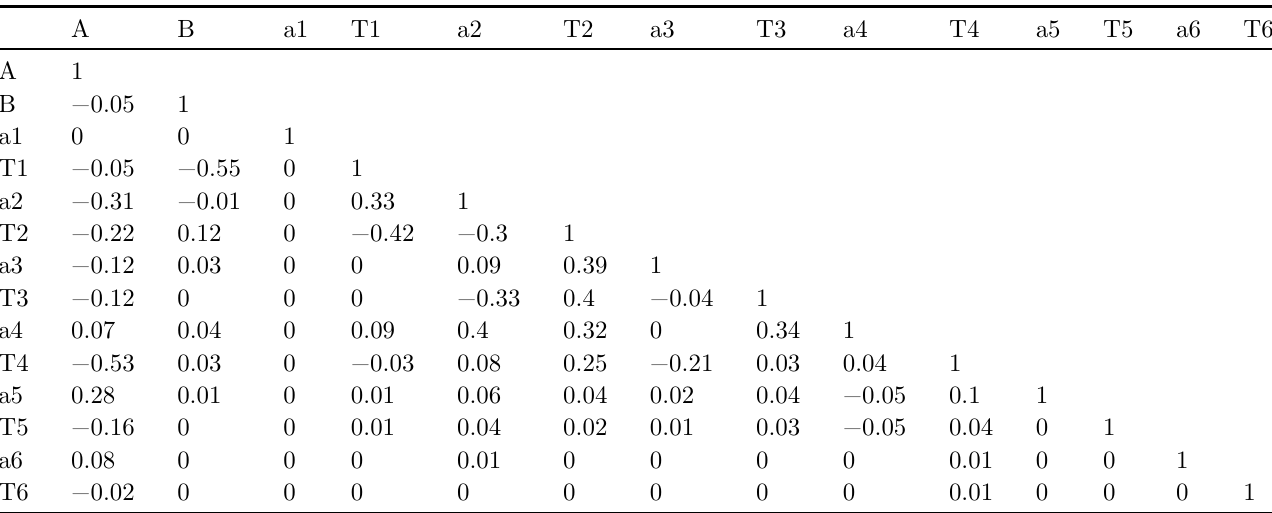
Table C8. The 6-group correlation matrix obtained in processing of the model decay curve calculated with the help of the 6-group DN “ input dataset ” ( A = 5000; B =